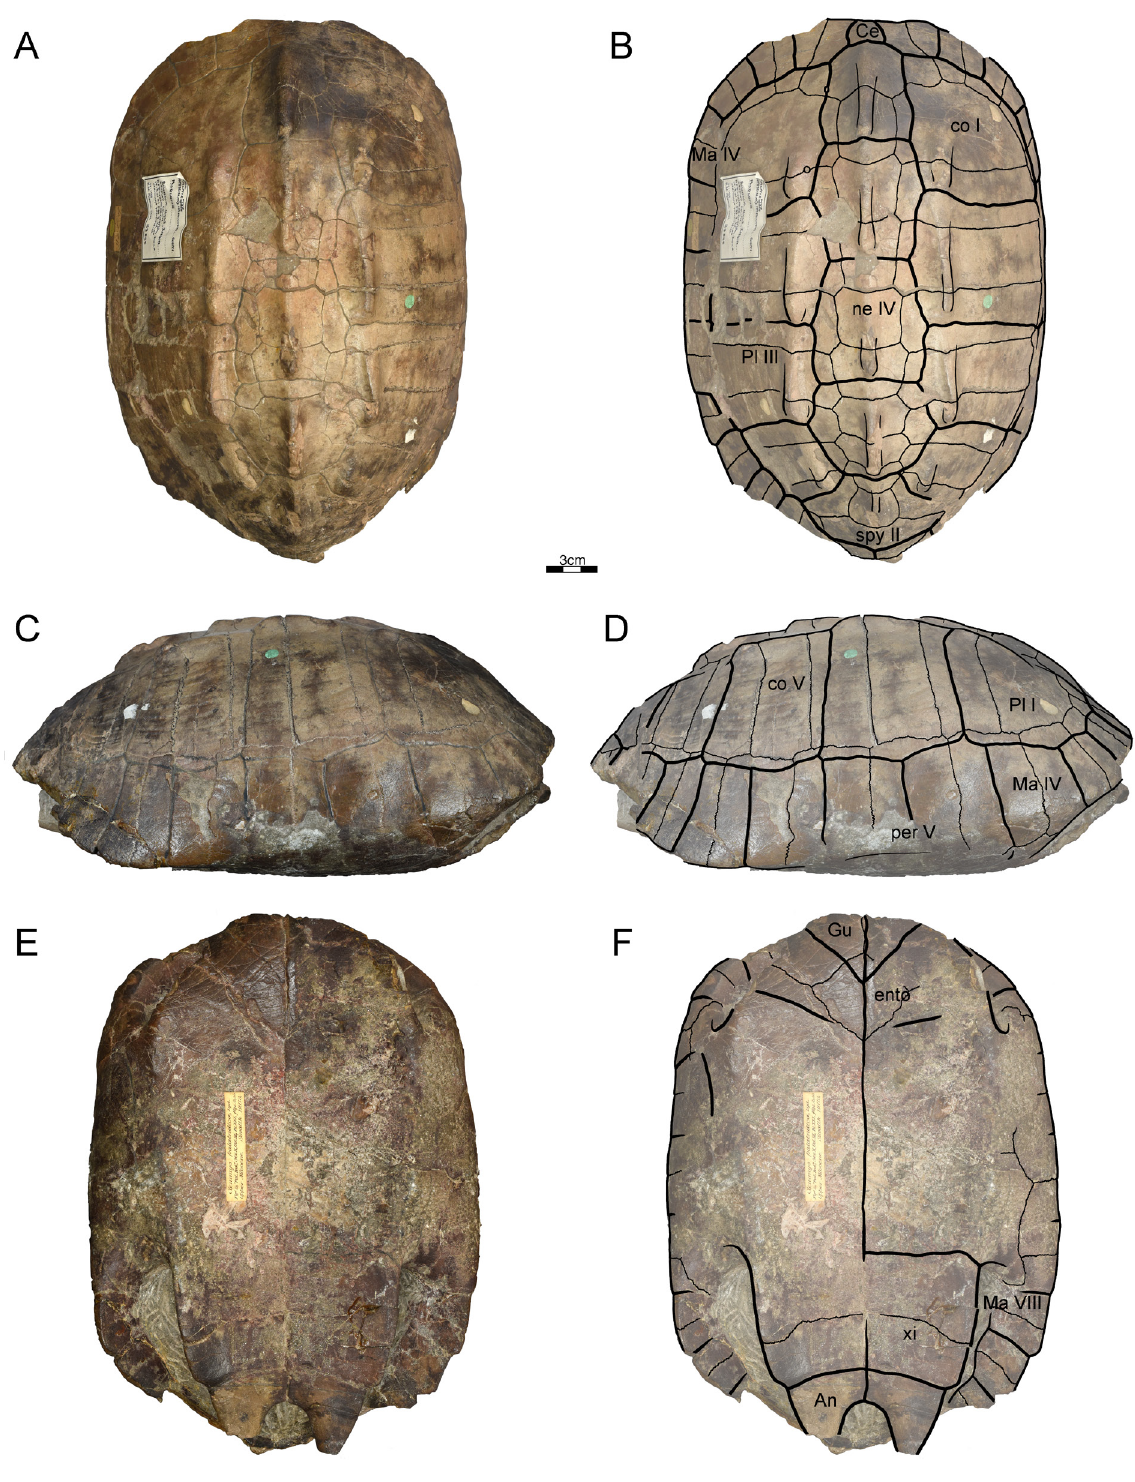
Fig. 22. BMNH 39838, holotype of Clemmys palaeindica Lydekker, 1885, here identified as synonym of Geoclemys hamiltonii (Gray, 1830). A . Photograph of carapace. B . Illustration of carapace. C . Photograph of carapace in lateral view. D . Illustration of carapace in lateral view. E . Photograph of plastron. F . Illustration of plastron. Scale bar: